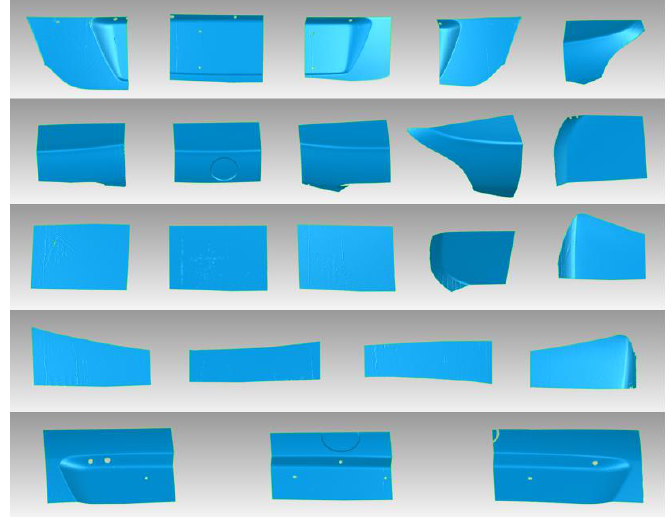
Figure 7. Surface point clouds of 22 times measurement represented in a form of triangular meshes.